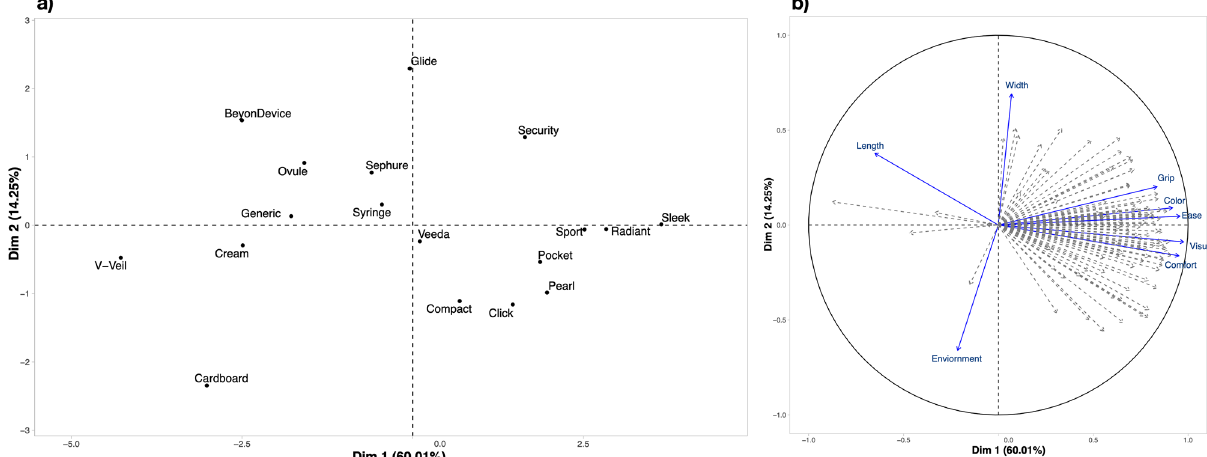
Figure 3. PCA biplot for the external preference map obtained from liking ratings and attribute ratings. Panel ( a ) shows the product plot using the first two principal components; that is, it shows the similarity of each product in relation to the others when all sensory attributes are reduced into two dimensions in PCA. Panel ( b ) shows the attribute and consumer liking loadings; that is, each participant’s liking vector is shown as a gray dashed line, while each sensory attribute vector is shown as a solid blue line, using the same two PC axes (i.e., the first two dimensions from the PCA, which explained 74.26% of the variance). Comparison of the consumer liking vectors to the sensory attribute vectors reveals attributes that drove liking/disliking. For example, products on the right side of the plot in Panel ( a ) were most liked (as shown by the dashed gray vectors in Panel ( b ) for each participant), and these products were in the opposite direction of the perceived length vector in Panel ( b ). Greater liking for products on the right side of Panel ( a ) is wholly consistent with means in Fig. 2. Collectively, the preference map indicates greater overall liking associates with scores for grip, color, ease, visual liking, and expected liking in the body, implying the increase in product liking was driven by specific product features and not merely familiarity. Also, the cardboard tampon applicator was perceived as being more environmentally friendly, but this was insufficient to drive an increase in liking for this disliked